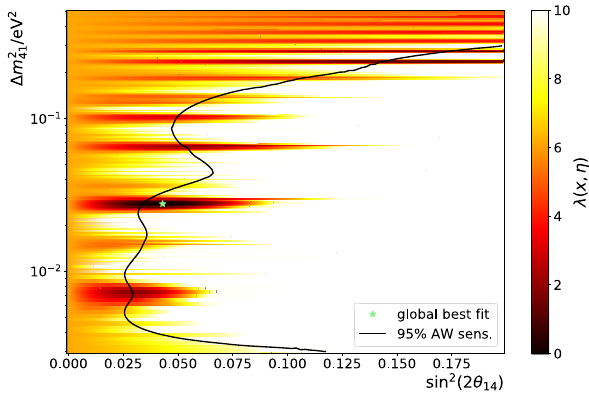
Fig. 9 Likelihood scan of the experimental